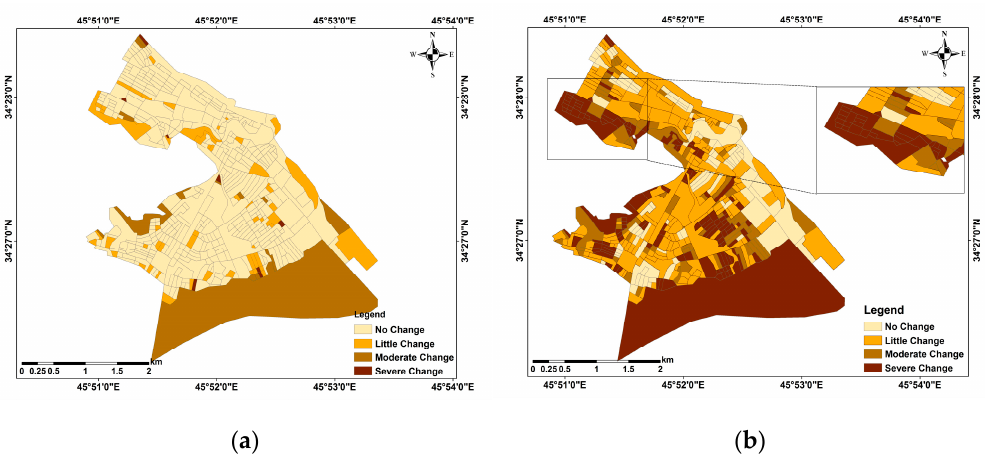
Figure 11. Sarpol Zahab standard deviation maps, ( a ) shows a lower standard deviation calculated with lighter colored street blocks before the earthquake disaster and ( b ) shows a higher standard deviation calculated with darker street blocks after the earthquake disaster.